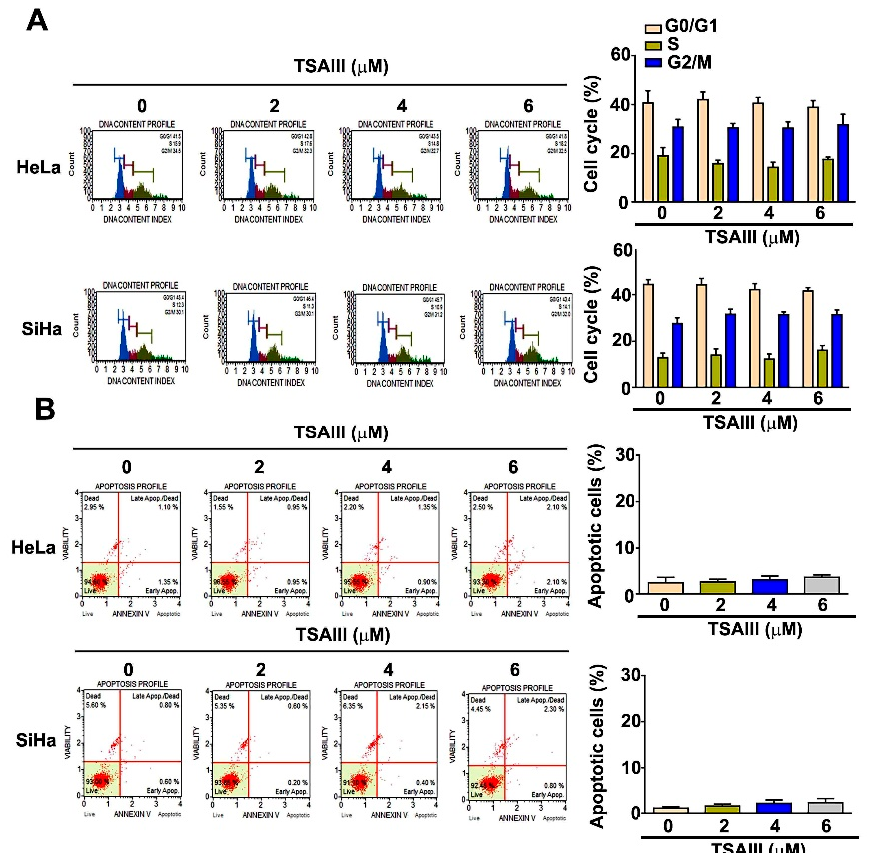
Figure 2. Effect of TSAIII on cell cycle arrest and apoptosis induction in human cervical cancer cells. ( A , B ) Regulation of cell cycle distribution and cell apoptosis in human HeLa and SiHa cervical cancer cells exposed to various concentrations (0, 2, 4 and 6 µM) of TSAIII was analyzed via flow cytometry (mean ± SE, n = 3) .